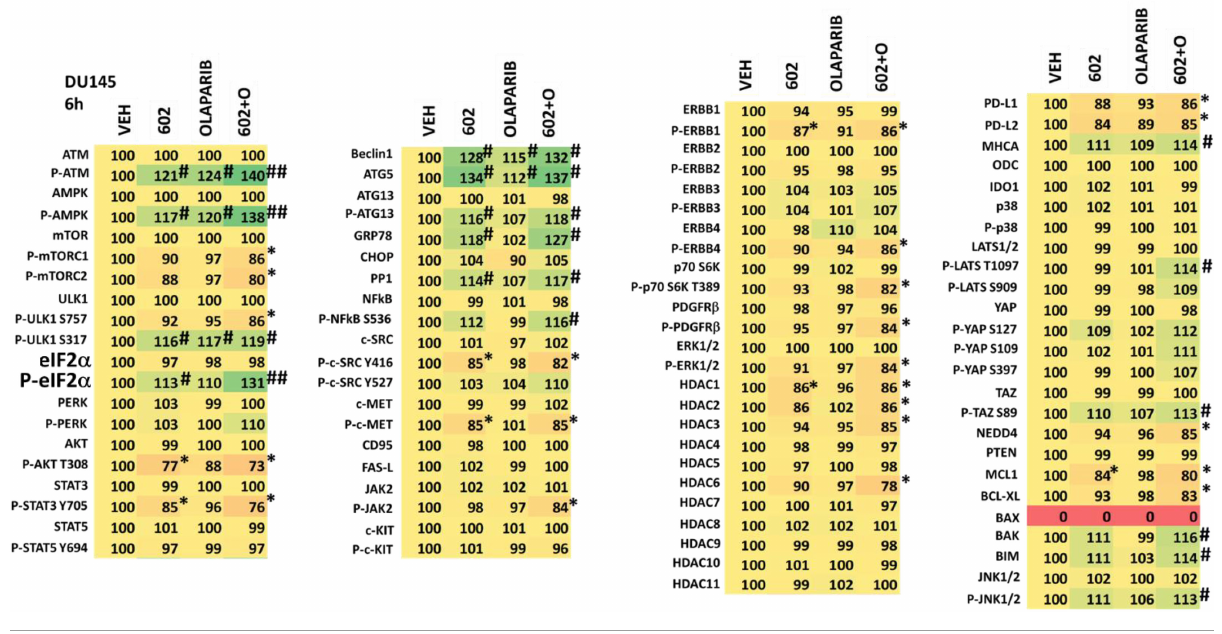
threeseparatestudies.Thedataarethenormalizedamountof fl uorescencesetat100%comparingintensityvaluesforvehiclecontrol(n=3+/-SD).#p<0.05greaterthanvehiclecontrol;* p < 0.05 less than vehicle. ## = greater than GZ17-6.02 as a single agent; ** = less than GZ17-6.02 as a single